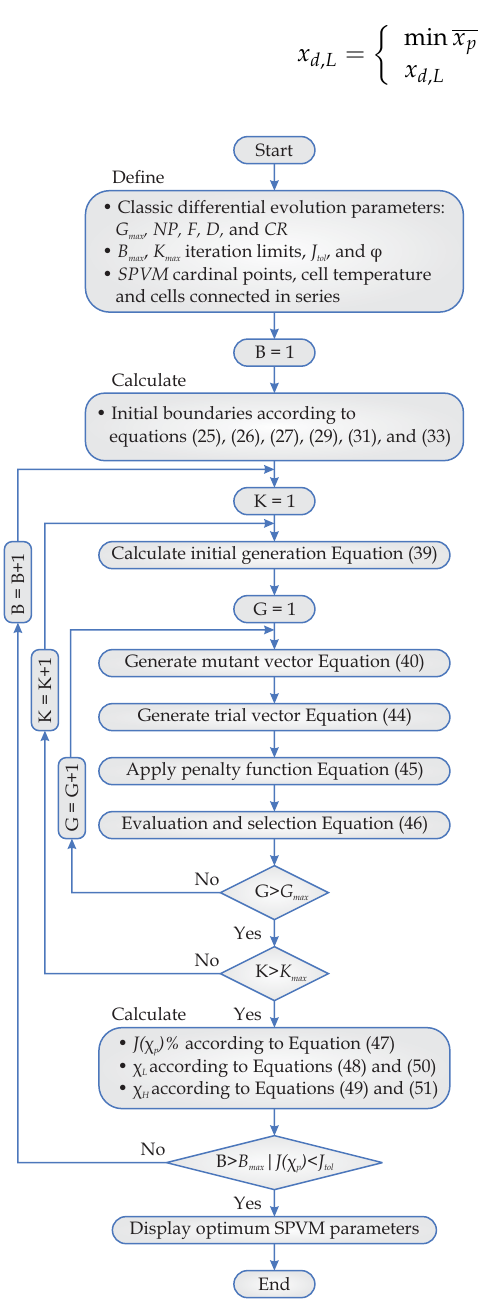
Figure 9. Flowchart for the modified differential evolution